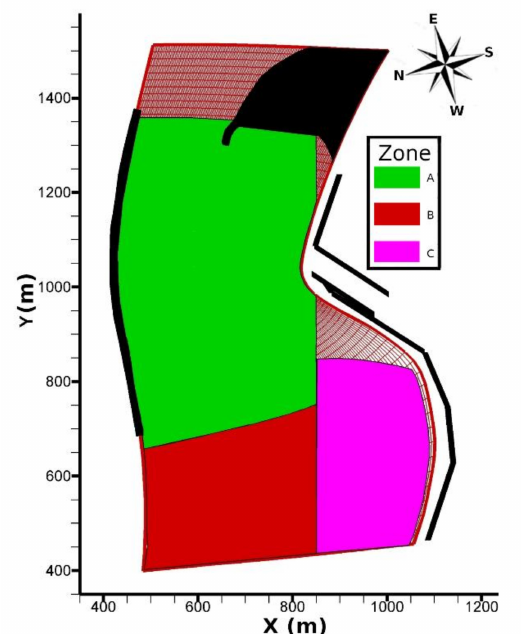
Figure 13. Zones partition for the evaluation of the volume of settled sediment. Configuration 1.